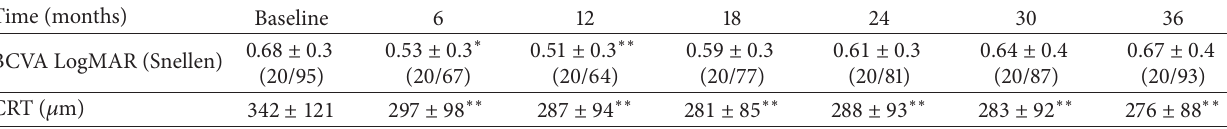
Table 2: Comparison of BCVA (LogMAR) and CRT (microns) during the